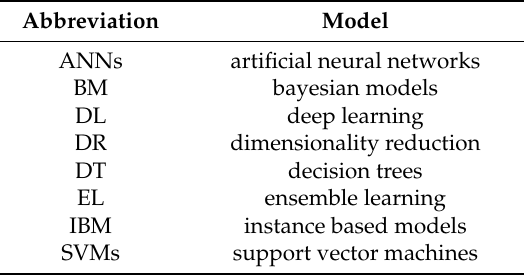
Table 1. Abbreviations for machine learning models.